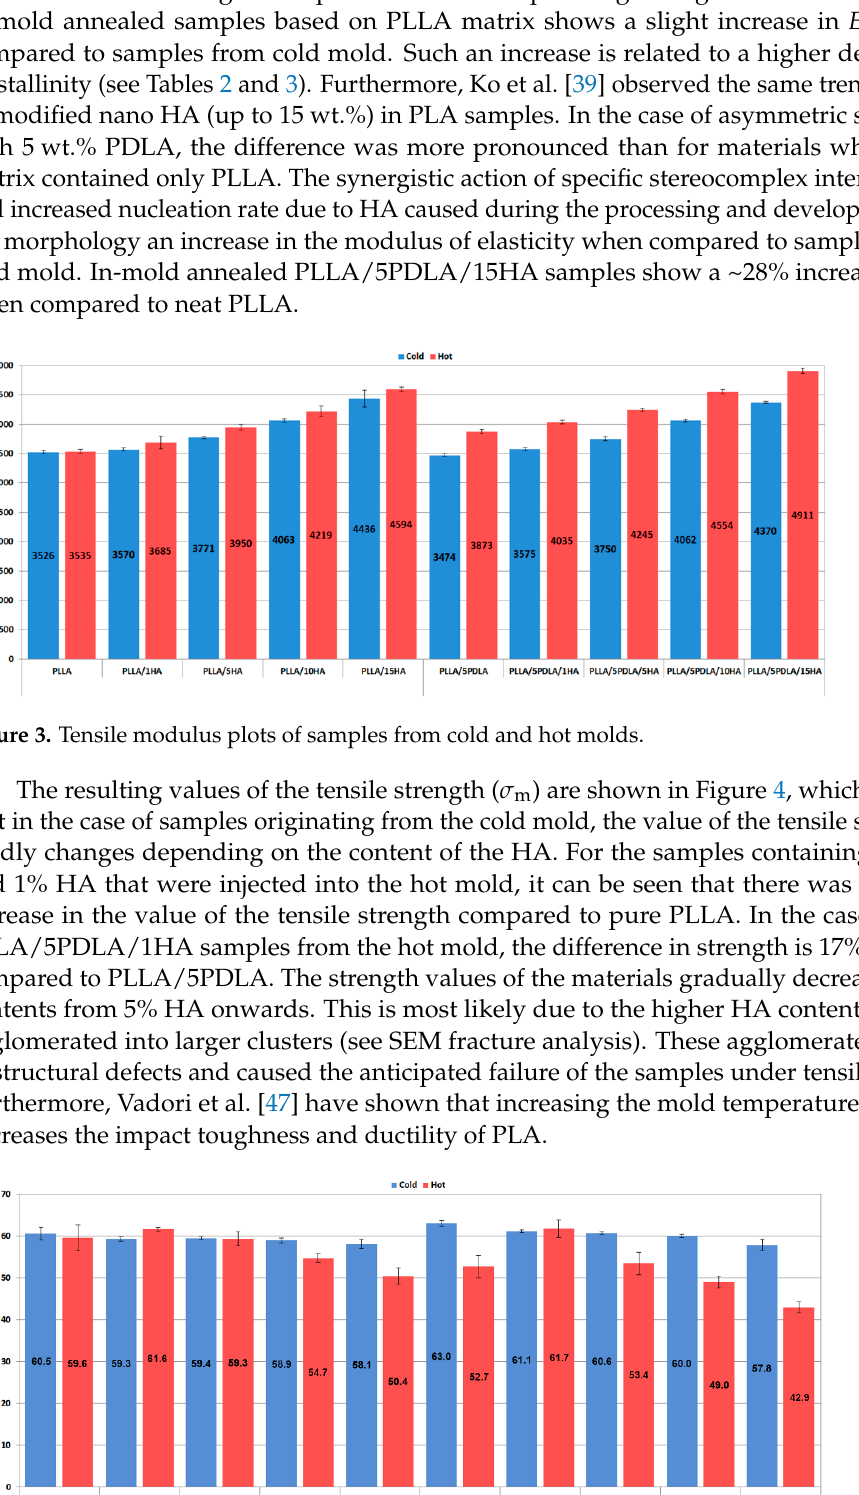
Figure 5. Elongation at break plots of samples from cold and hot molds. From the plots in Figure 6 it can be seen that the in-mold annealed specimens with PLLA matrix have higher impact toughness ( a cU ) compared to the specimens from the cold mold. The highest values were observed for in-mold annealed PLLA/1HA nanocompo- sites. The same trend has been observed by Kawamoto et al. [48] using different nucleation agents. High-temperature molding (110 °C) of PLLA and nucleating agents based on a mix of ethylenebis-(12-hydroxystearylamide) (EBHS)/talc (1 wt.% each) and octameth- ylenedicarboxylicdibenzoylhydrazide (OMBH) at 1 wt.% loading. Furthermore, the value of impact toughness decreased with an increasing percentage of HA in PLLA. A similar trend of the impact toughness was observed for the samples originating from the hot mould with a base matrix containing 5 wt.% PDLA.